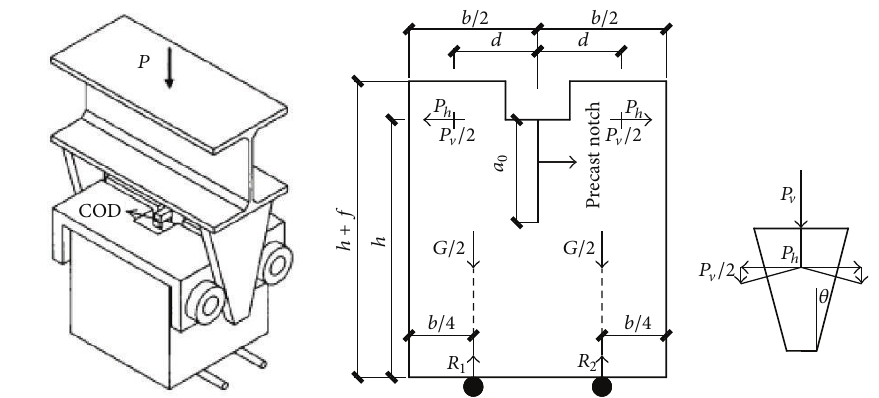
Figure 2: Test setup and geometry of